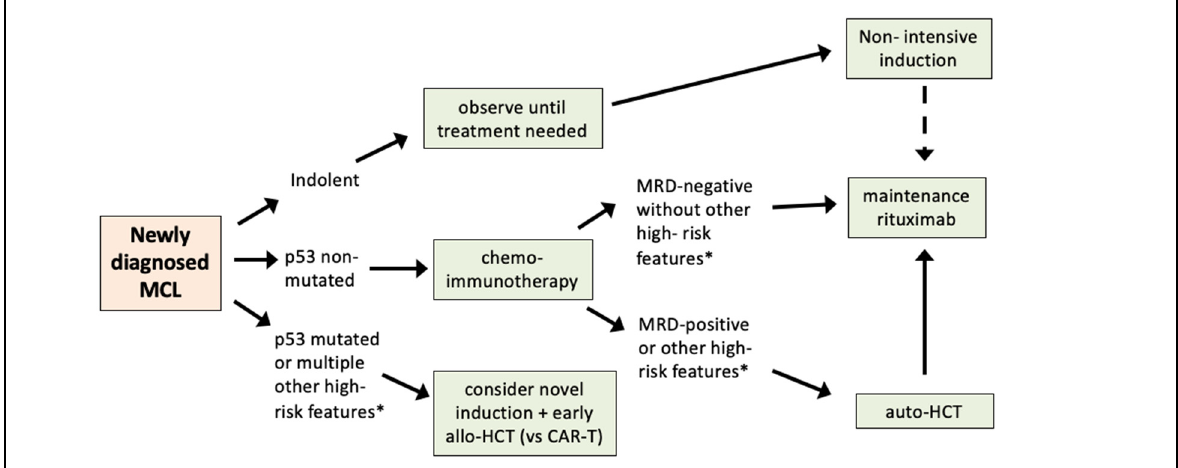
Figure 1. Proposed risk-adapted approach to first-line therapy of MCL. CAR-T = chimeric antigen receptor T-cells, auto-HCT = autologous hematopoietic stem cell transplant, MRD = measurable residual disease. * High-risk features include MIPI-c, complex karyotype, high risk genomic alterations (KMT2D, CDKN2A), and perhaps (in the future) MCL-35. Note: omission of auto-HCT based on MRD-negative status alone cannot be recommended until the results of ECOG-ACRIN 4151 are available.